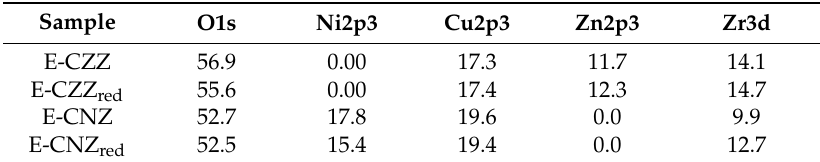
Table 2. Comparison of the atomic concentration in the outer support layers for the calcined and reduced samples E-CZZ and